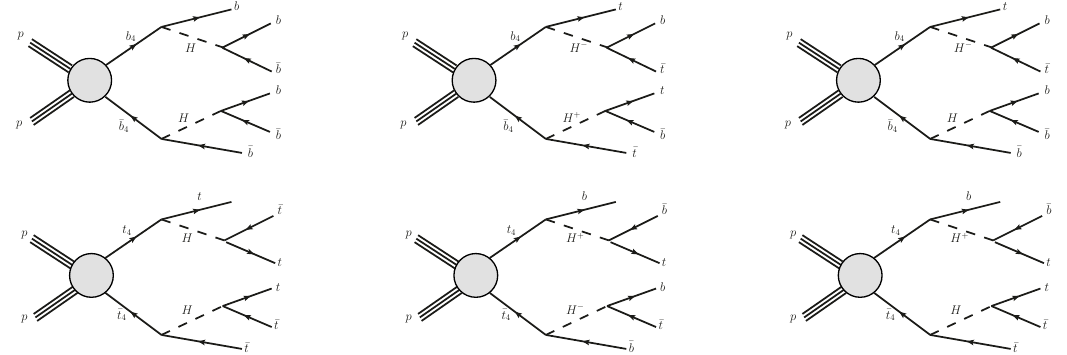
Figure 1 . Representative cascade decays of pair produced vectorlike top and bottom quarks through neutral Higgs bosons (left), charged Higgs bosons (middle), and mixed cases of one decaying through a neutral and the other through a charged Higgs boson